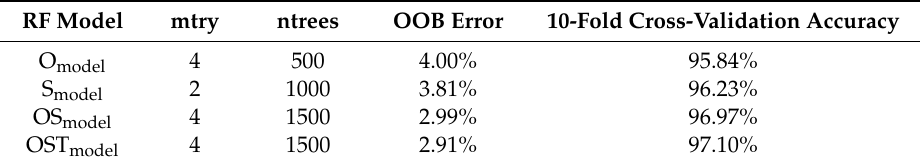
Figure 4. Coastal wetland maps of the Beidagang predicted by different random forest models: ( a ) O model , ( b ) S model , ( c ) OS model , and ( d ) OST model . Table 2. Parameters and error statistics of the random forest